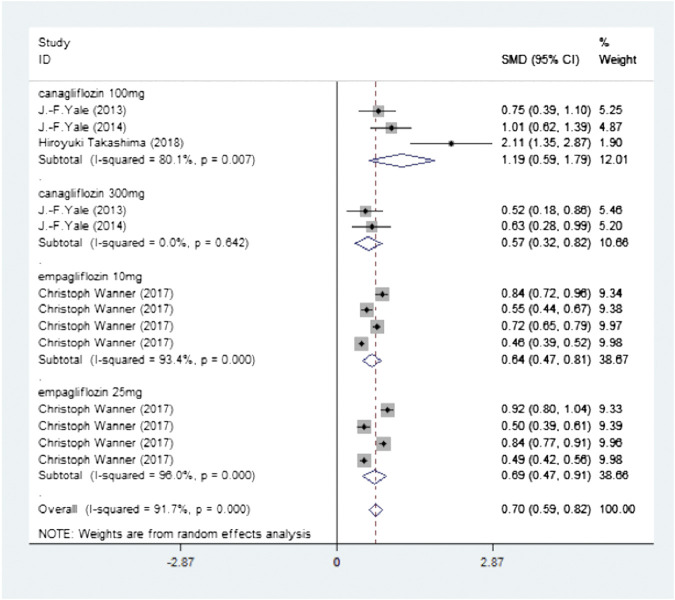
Meta-analysis and forest plot of hemoglobin levels in the experimental and the control groups.